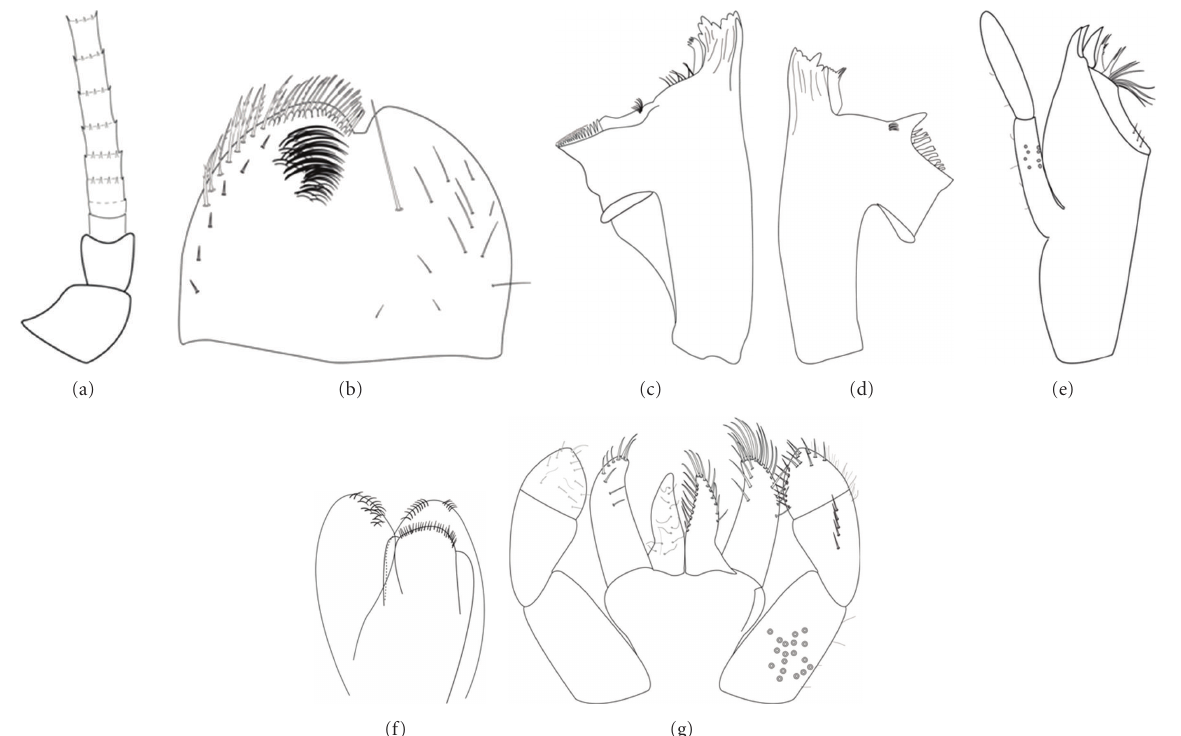
Figure 1: Fallceon sp. V1 . (a) antenna; (b) labrum (dorsal view); (c) right mandible; (d) left mandible; (e) maxilla; (f) hypopharynx; (g) labium (left ventral view and right dorsal